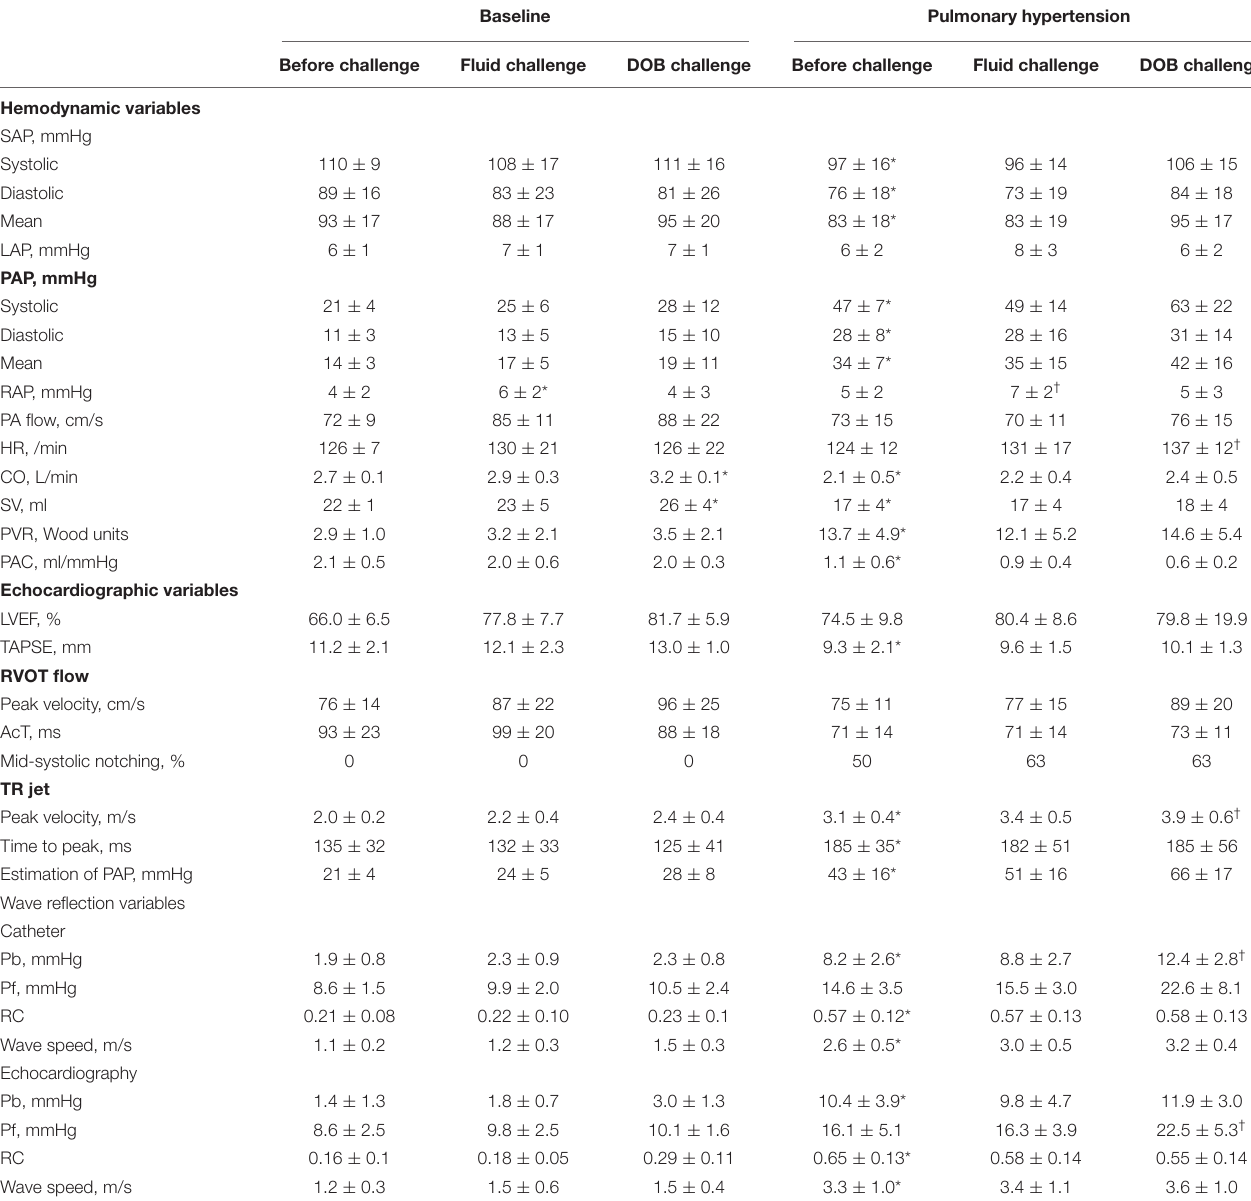
TABLE 1 | The changes in hemodynamic variables obtained invasively and echocardiographic variables, wave reflection